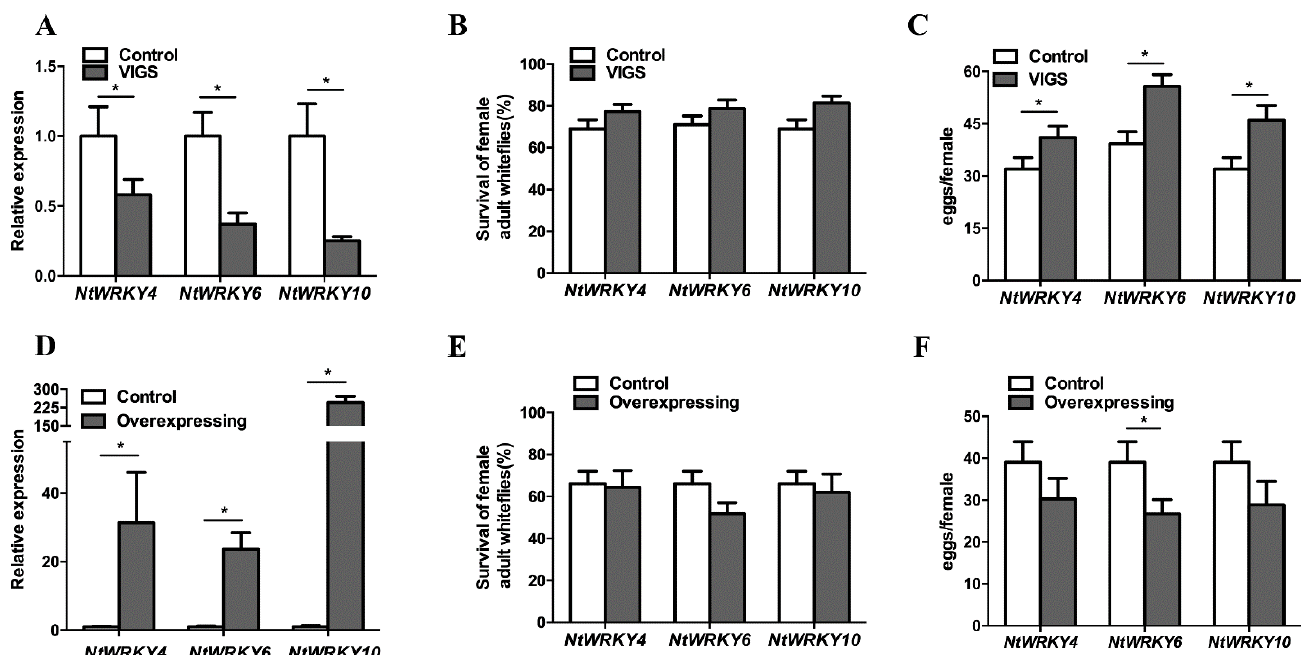
Figure 3. NtWRKY4 , NtWRKY6 , and NtWRKY10 positively regulated tobacco defense against whiteflies. ( A ) Expression levels of NtWRKY4 , NtWRKY6 , and NtWRKY10 in silenced plants. ( B ) Survival rates of whiteflies on NtWRKY4 -, NtWRKY6 -, and NtWRKY10 -silenced plants. ( C ) The fecundities of whiteflies on NtWRKY4 -, NtWRKY6 -, and NtWRKY10 -silenced plants. ( D ) Expression levels of NtWRKY4 , NtWRKY6 , and NtWRKY10 in transgenic overexpressed plants. ( E ) Survival rates of whiteflies on NtWRKY4 -, NtWRKY6 -, and NtWRKY10 -overexpressing plants and controls. ( F ) The fecundities of whiteflies on NtWRKY4 -, NtWRKY6 -, and NtWRKY10 -overexpressing plants. The gene expression levels of the control and VIGS (or overexpressing) plants in each of the treatments was analyzed using Student’s t test at a significance of * p < 0.05; the percentages of whitefly survival among the three controls and VIGS (or overexpressing) plants were analyzed using one-way ANOVA at a significance of * p < 0.05; similarly the numbers of eggs laid per female among the three controls and VIGS (or overexpressing) were analyzed using one-way ANOVA at a significance of * p < 0.05.